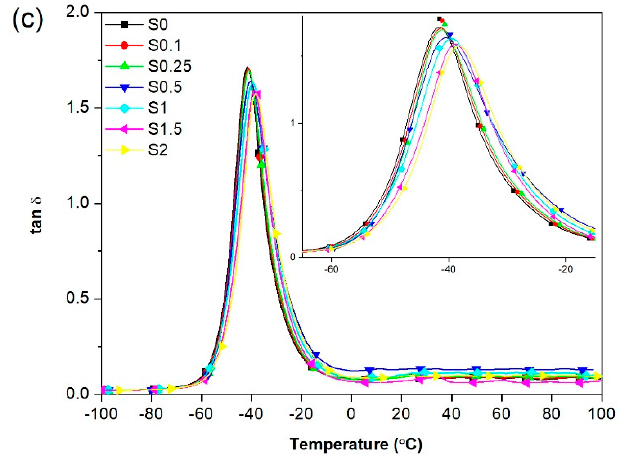
Figure 9. Dynamic properties of NR/CNT/GNS nanocomposite foams as a function of temperature: ( a ) variation of storage modulus (E’), ( b ) variation of loss modulus (E”), and ( c ) variation of dissipation peak (tan δ ).